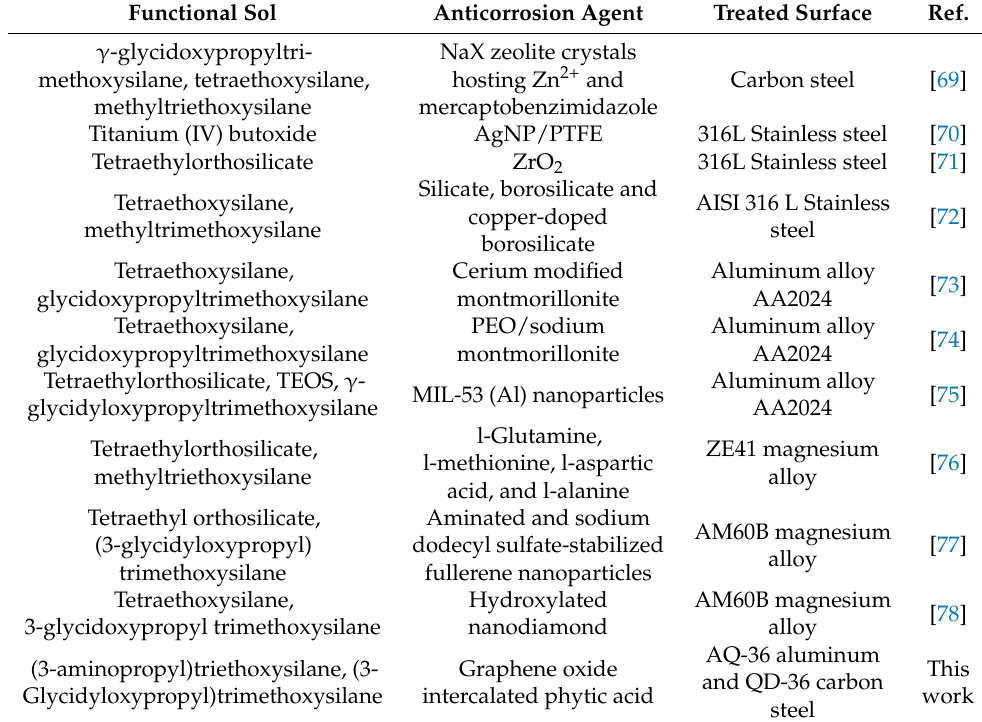
Table 1. Recent sol–gel-based functional coatings for anticorrosion treatments of different surfaces. Functional Sol Treated Surface